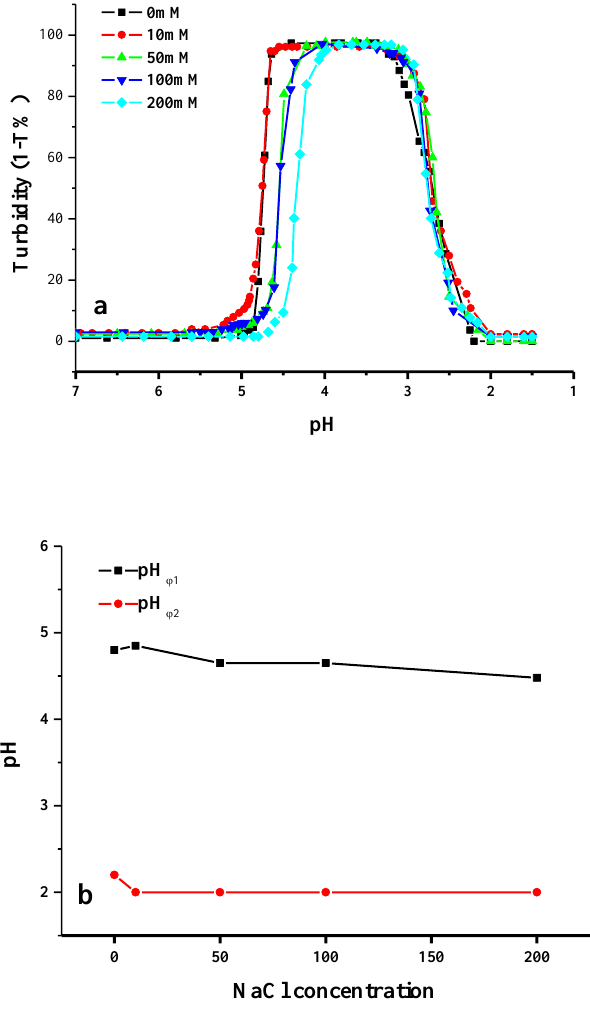
Figure 6. The turbidimetric titration curves of CMI/BSA mixtures as a function of pH at different C NaCl at CMI/BSA ratio (r) = 1:5 ( a ) and the variation of pH φ1 and pH φ2 as a function of C NaCl ( b ).